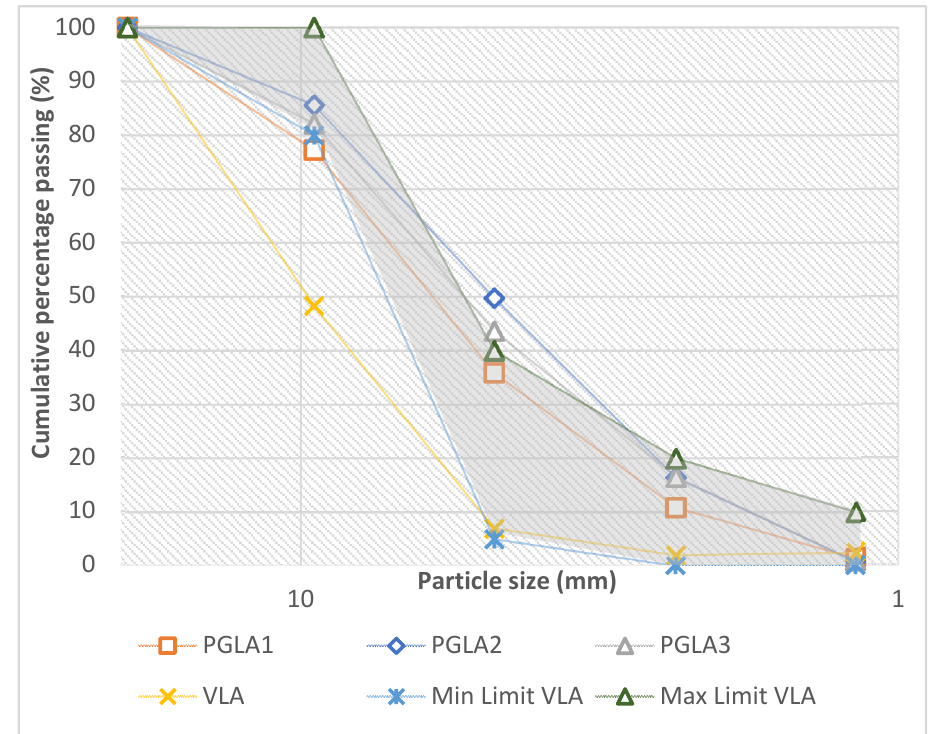
Figure 7. Particle size distribution curves for PGLAs and VLA.